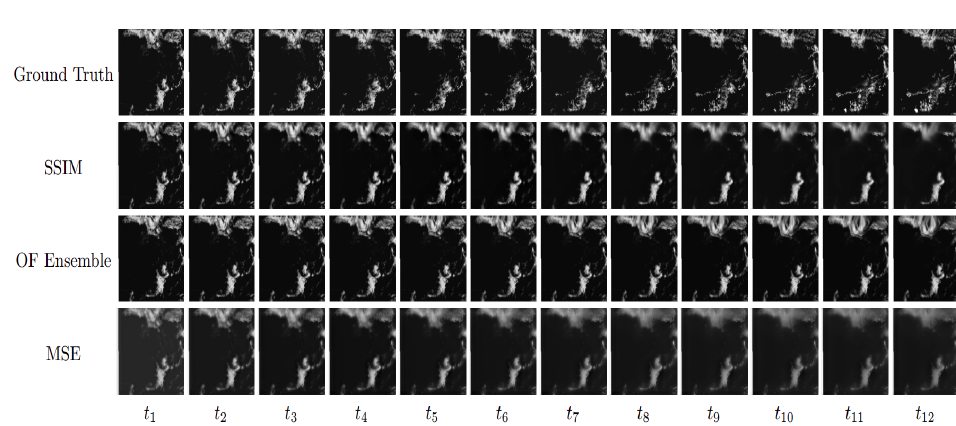
Figure A3. Example 3 h nowcasts over Spain on 5 September 2019.